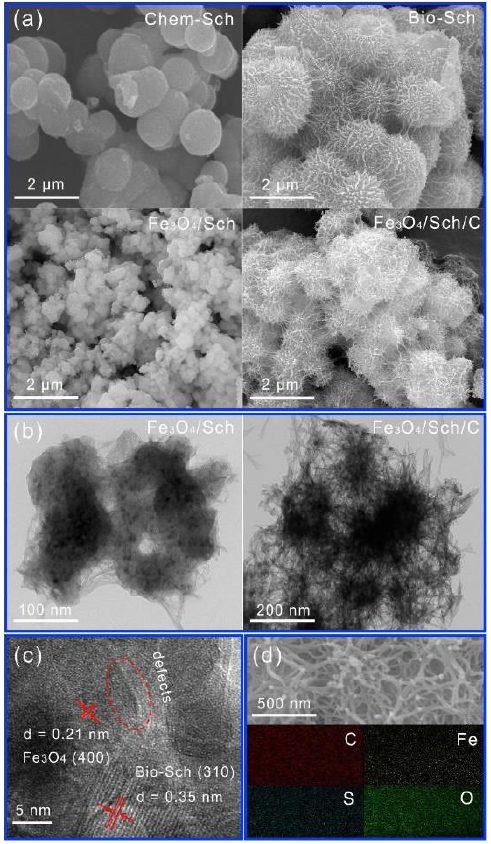
Figure 3. ( a ) SEM images of Chem-Sch, Bio-Sch, Fe 3 O 4 /Sch, Fe 3 O 4 /Sch/C, ( b ) TEM of Fe 3 O 4 /Sch and Fe 3 O 4 /Sch/C, ( c ) HRTEM of Fe 3 O 4 /Sch/C, and ( d ) elemental mapping of different elements C, Fe, S, and O recorded from Fe 3 O 4 /Sch/C [60].